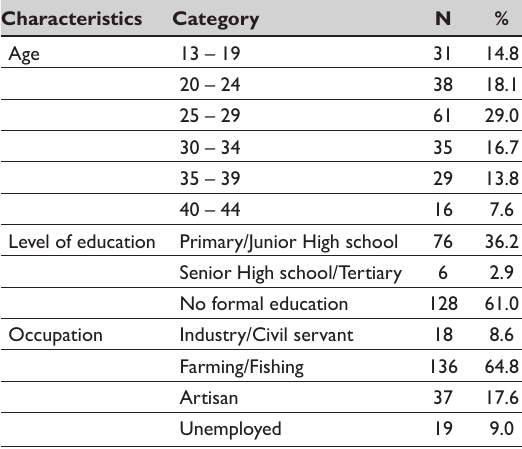
Table 1: Background characteristics of